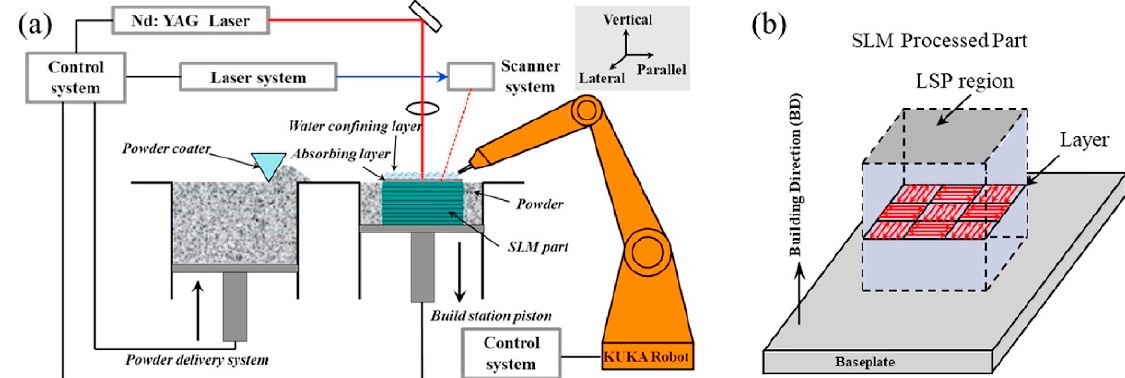
Figure 19. Integrated SLM with LSP ( a ) Process diagram and ( b ) laser scanning strategy. Reproduced with permission from [136]. Copyright Elsevier, 2020.